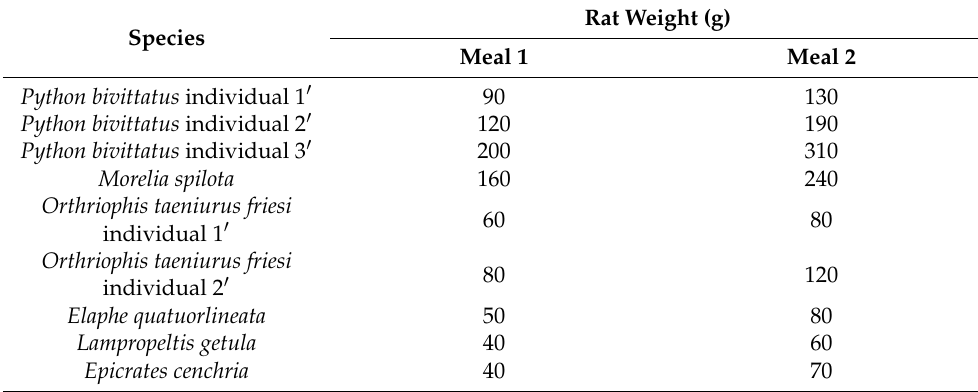
Table 1. Weight of rats fed to each snake for both rounds of